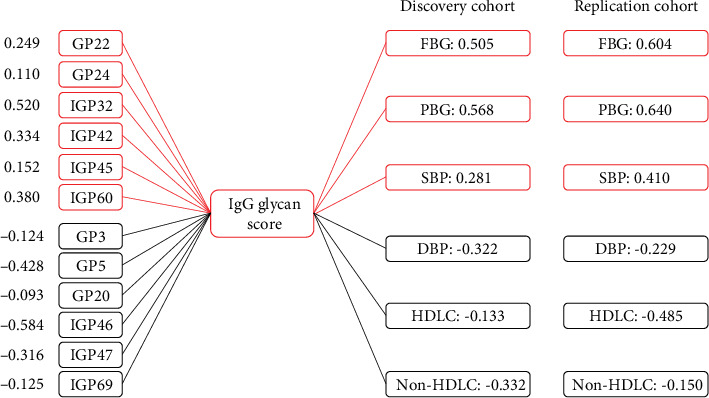
Composition of the IgG glycan score and its correlations with clinical traits in the discovery and replication populations. Red: positively correlated with the glycan score; blue: negatively correlated with the glycan score; FBG: fasting blood glucose; PBG: two-hour postprandial blood glucose; SBP: systolic blood pressure; DBP: diastolic blood pressure; HDL-cholesterol: high-density lipoprotein cholesterol; nonHDL-cholesterol: non-high-density lipoprotein cholesterol.